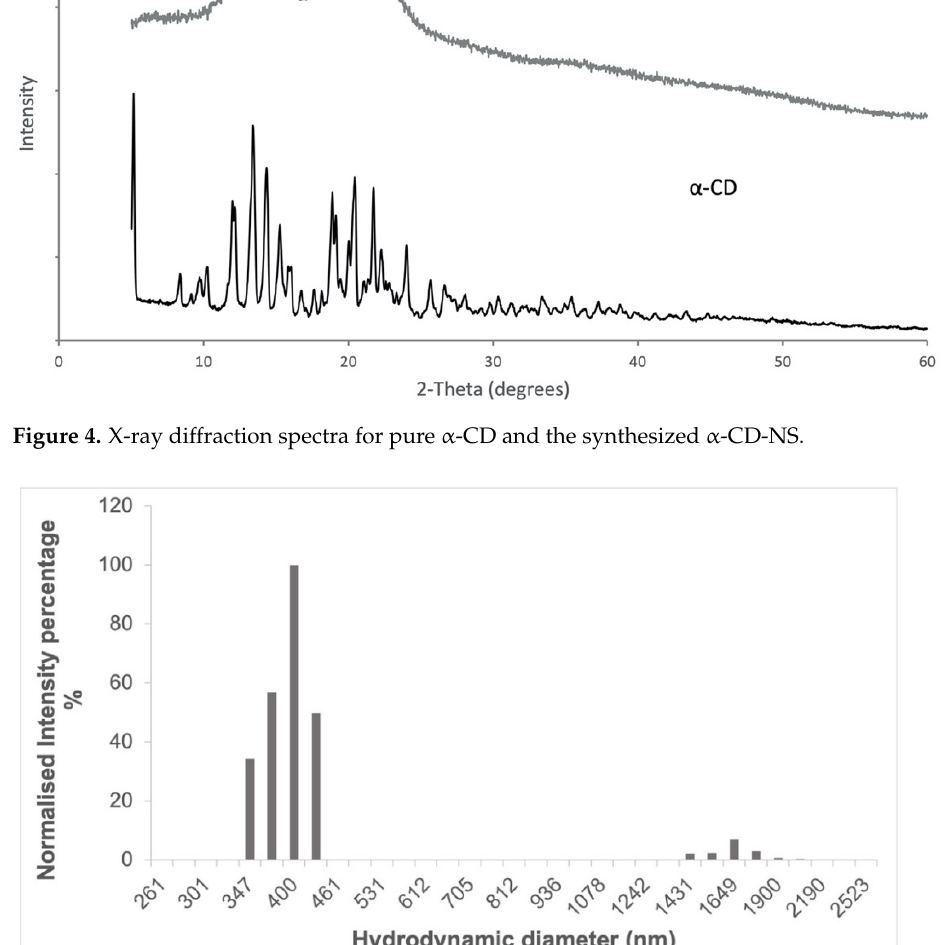
Figure 5. Size distribution of ball mill synthesized α -CD-NS after washing determined by dynamic light scattering (DLS).